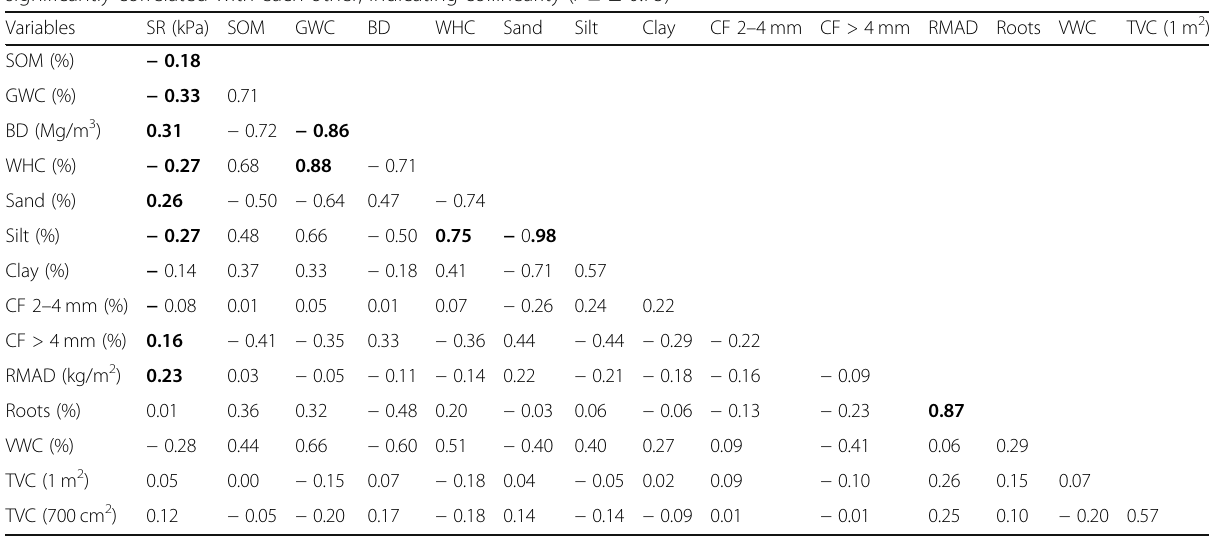
Table 1 Pearson ’ s product-moment correlation ( r ) matrix results for the soil resistance (SR) response variable and 14 explanatory variables. Explanatory variables derived from soils sampled over a 3-week period in subalpine meadows ( n = 5) at Yosemite National Park, USA: group A ( n = 252) bulk density (BD), gravimetric water content (GWC), volumetric water content (VWC), total vegetation cover (TVC 1 m 2 ), TVC 700 cm 2 , coarse fragment content (CF) 2 – 4 mm, CF > 4 mm, root mass areal density (RMAD), and root content (roots %), group B ( n = 98): water holding capacity (WHC), soil organic matter content (SOM), and sand, silt, and clay. Bolded values represent variables significantly correlated with SR ( r > ± 0.16, p < 0.05 for n = 252 and r > ± 0.20, p < 0.05 for n = 98), or significantly correlated with each other, indicating collinearity ( r ≥ ±